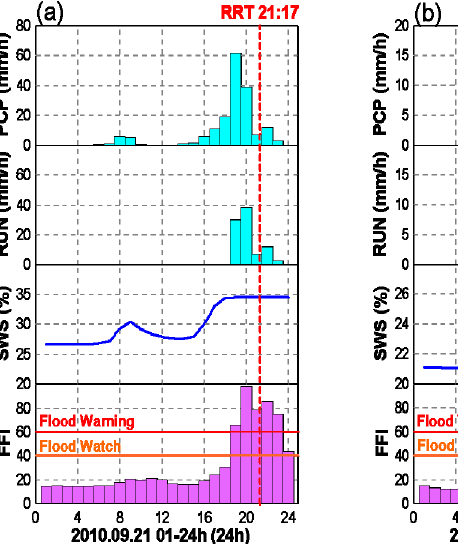
Figure 9. Time series of simulated hydrological components for the flash flooding cases on ( a ) 21 September 2010, ( b ) 19 July 2012, and ( c ) 14 August 2011. The x-axis is time (h), and the panels from top to bottom indicate Precipitation (PCP, mm/h), Surface Runoff (RUN, mm/h), Soil Water Content (SWS, %), and statistical flash flooding risk index (FFRI). The vertical dashed red lines are Rescue Request Time (RRT), and the horizontal red and orange lines are the predetermined flood warning and flood watch, respectively.